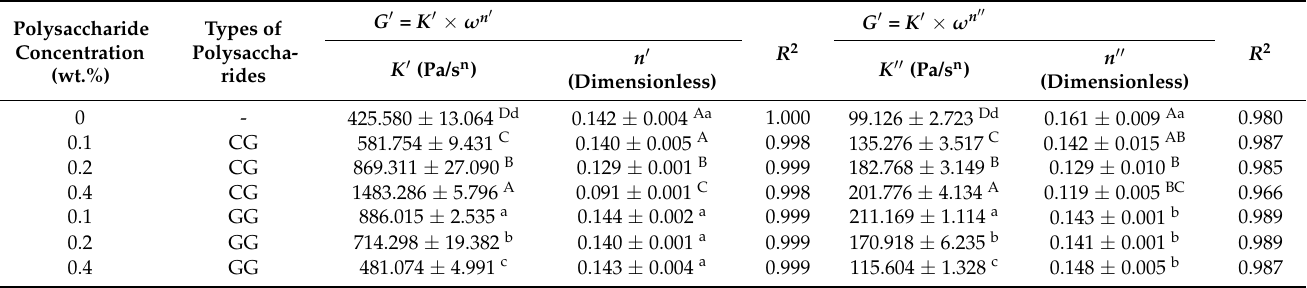
Table 1. The Power Law model parameters fitting results of PC-CG and PC-GG gels at various polysaccharide concentrations.